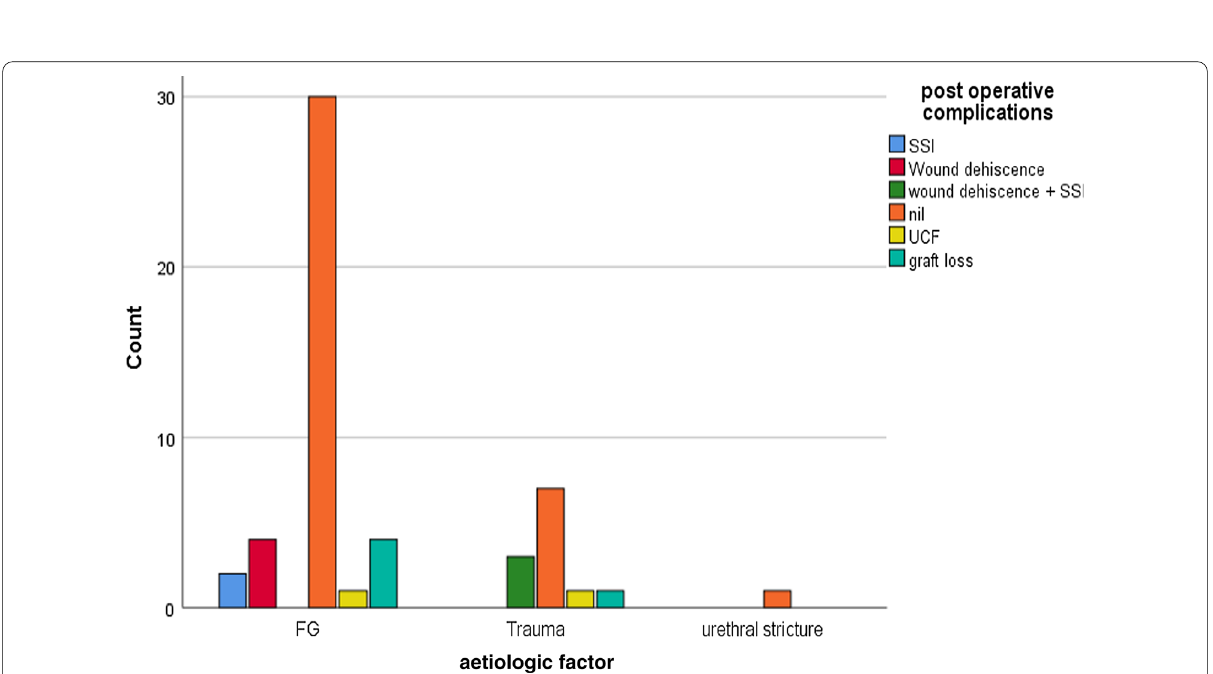
Fig. 6 A bar chart showing distribution of complications in Fournier’s gangrene (FG) and trauma